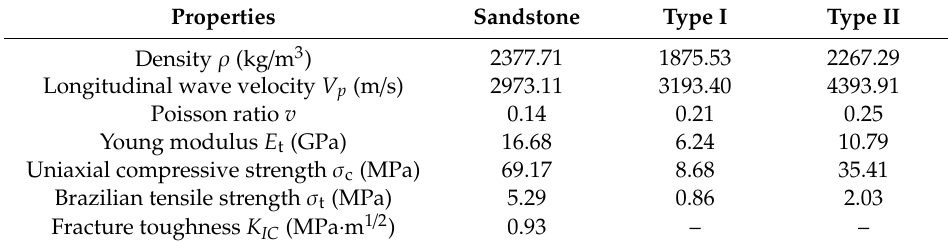
Table 1. Some essential physical and mechanical properties of the tested sandstone and inclusions